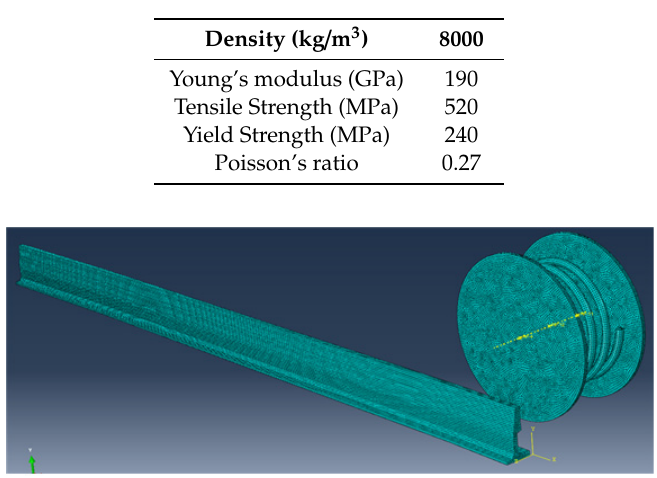
Figure 3. The finite elements of the whole geometry.